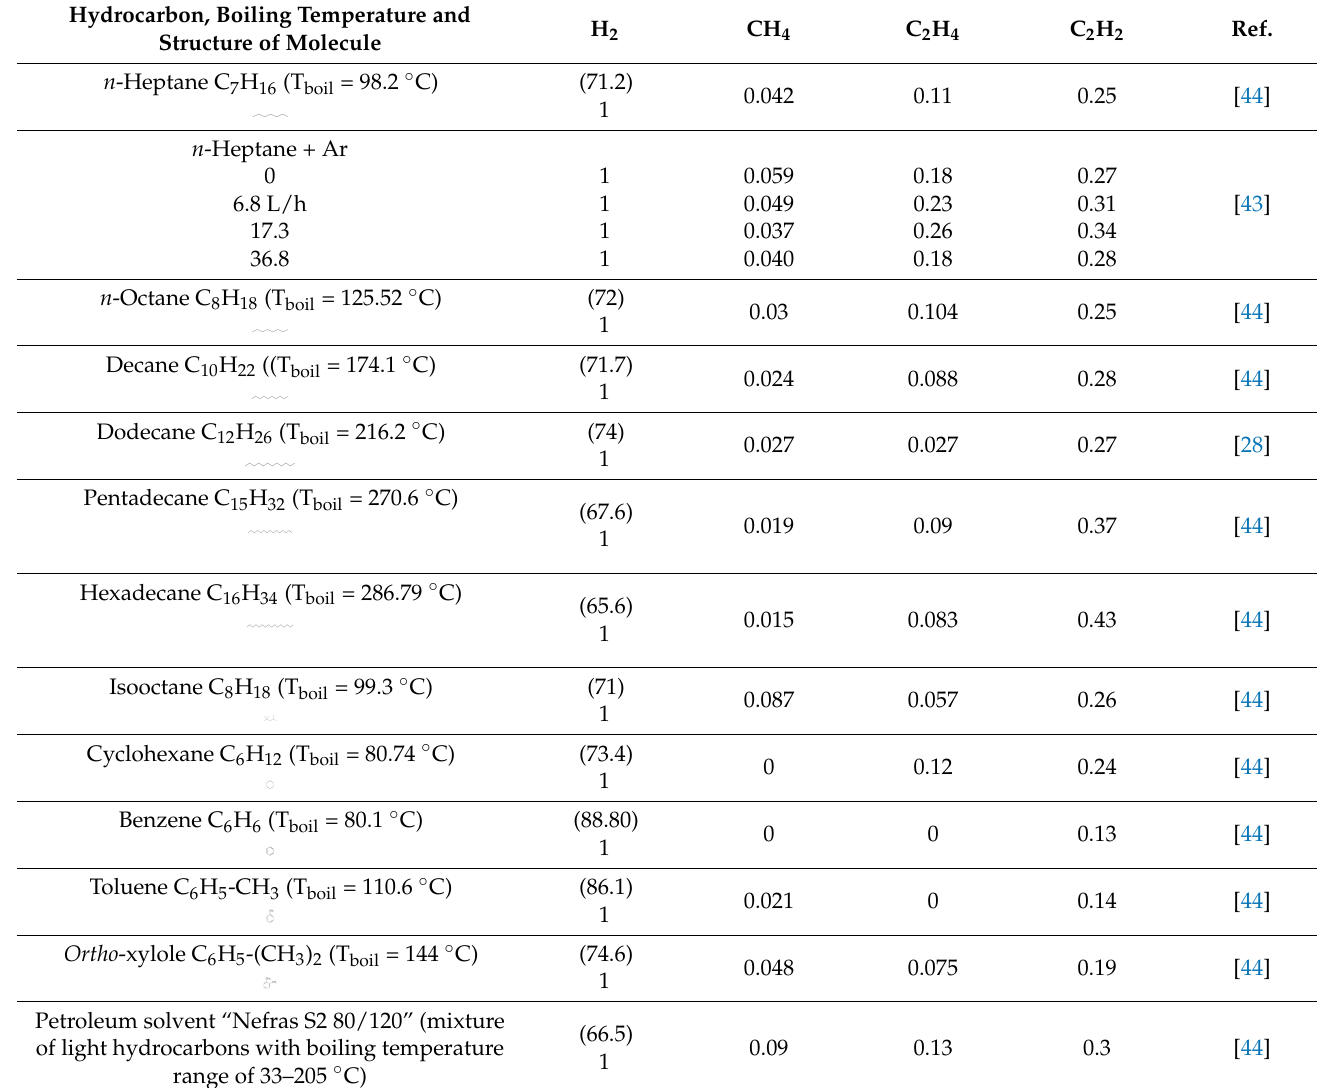
Table 2. Relative volume concentrations (relative to hydrogen concentration) of the main gas products of microwave dis- charges in liquid hydrocarbons at atmospheric pressure (numbers in brackets show the volume concentration of hydrogen). Hydrocarbon, Boiling Temperature